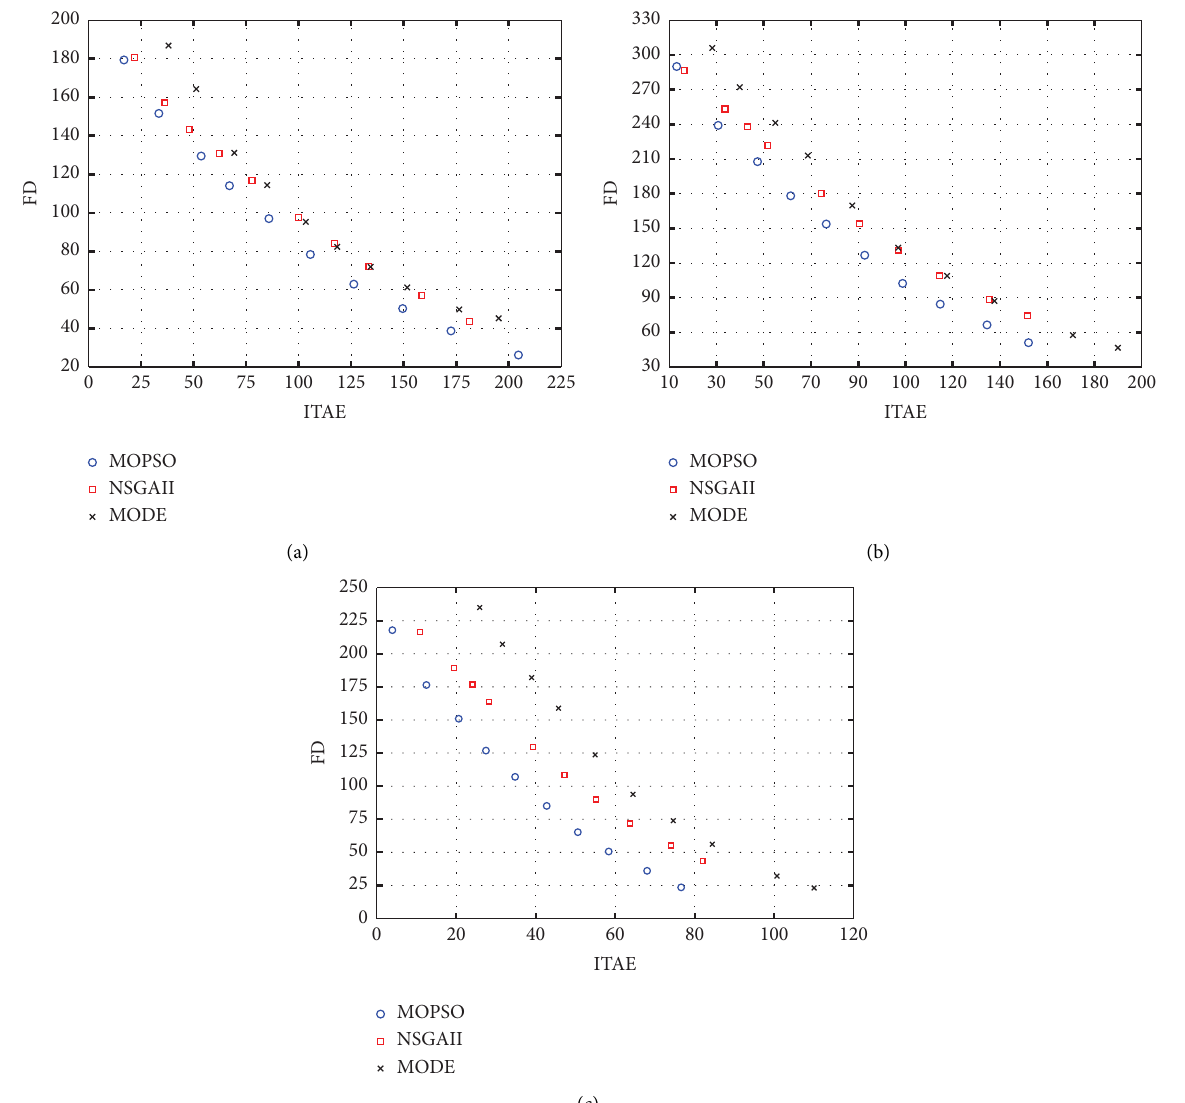
Figure 14: Te dominant values at the presence of (a) PSS2B, (b) TCSC, (c) PSS2B, and TCSC, at the same